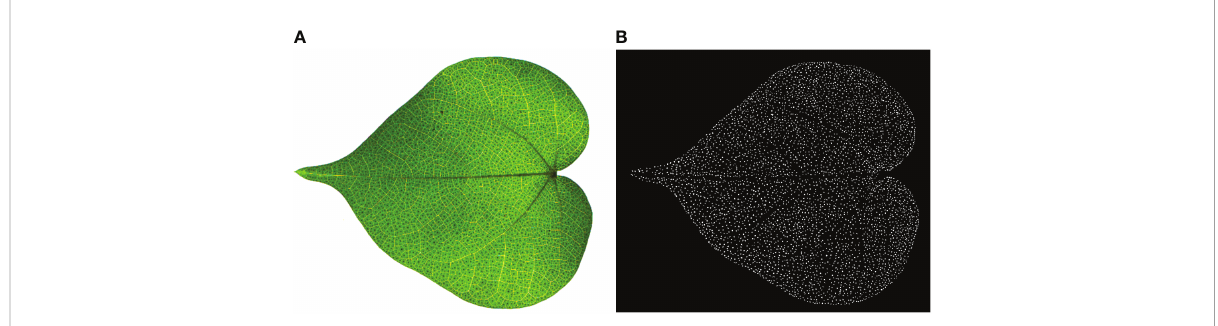
FIGURE 3 Manual labeling of cotton leaves at seedling stage. (A) Original image; (B) Annotated image. The background is in black, and the cotton pigment glands are in white.